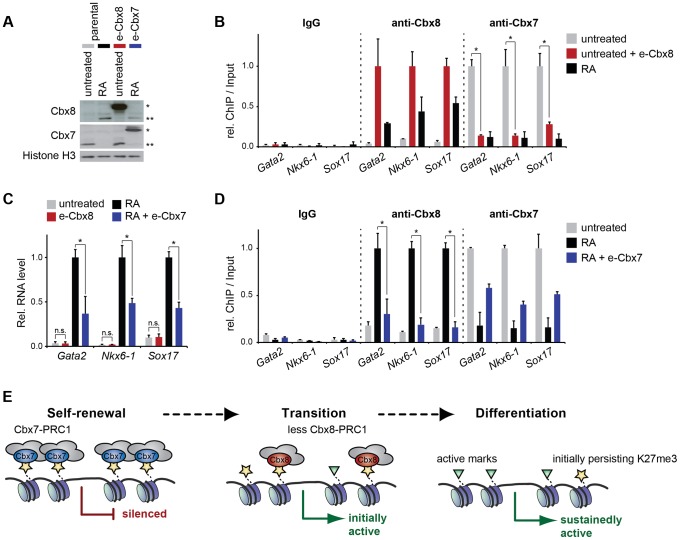
The exchange of Cbx7 for Cbx8 is required but not sufficient to promote the differentiation of mES cells.(A-D) Parental ES cells treated with RA for three days or left untreated were compared to untreated ES cells expressing exogenous Cbx8 and differentiating ES treated with RA for three days and expressing exogenous Cbx7. Consistent color coding of cells and treatments is as indicated in A. (A) The expression levels of endogenous and exogenous epitope (e)-tagged Cbx proteins is shown by Western blot of lysates from stable transfected ES cells (e-Cbx7 and e-Cbx8, respectively) and parental control cells. Exogenous and endogenous protein bands are marked by one or two asterisks, respectively. Cells were treated with RA for three days as indicated. Histone H3 was used as loading control. (B) The occupancy of Cbx7 and Cbx8 on selected genes was analyzed by ChIP in untreated ES cells overexpressing Cbx8 (red bars) and parental control cells treated with RA for three days (black bars) or left untreated (grey bars). ChIP-Input ratios for each gene and antibody are shown relative to the maximal enrichment. IgG is shown relative to Cbx8 ChIP. Error bars denote s.d.; n = 3; * = p<0.05. (C) Relative mRNA levels of the same genes as in B measured by qRT-PCR are shown. Error bars denote s.d.; n = 3; * = p<0.05; n.s.  =  not significant. (D) ChIP of Cbx8 or Cbx7 in Cbx7-overexpressing cells treated with RA for three days (blue bars) and control cells treated with RA (black bars) or left untreated (grey bars). ChIP-Input ratios for each gene and antibody are shown relative to the maximal enrichment. IgG is shown relative to Cbx8 ChIP. Error bars denote s.d.; n = 3; * = p<0.05. (E) Cartoon illustrating our finding that Cbx8-containing PRC1 complexes replace Cbx7-containing PRC1 complexes during the initial activation of differentiation genes. During a metastable transition state binding of Cbx8-containing PRC1 co-occurs with the presence of both repressive marks such as H3K27me3 and active marks such as H3K36me3. Prolonged activation results in loss of Cbx8-containing PRC1 that precedes the removal of H3K27me3.